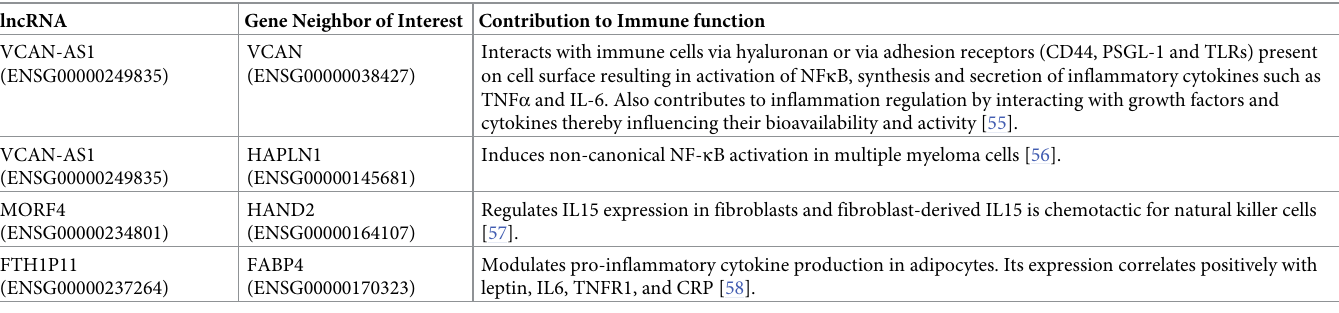
Table 2. Identities, ensembl numbers, and functions of neighboring genes that have a potential to be involved in immune response. lncRNA Gene Neighbor of Interest Contribution to Immune function VCAN-AS1